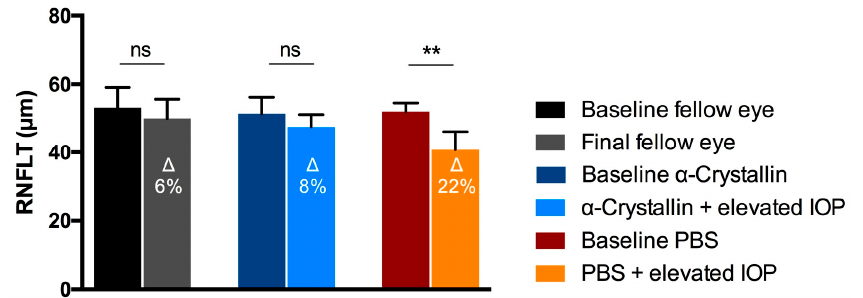
Figure 3. Survey of the retinal nerve fiber layer thickness using optical coherence tomography. Untreated contralateral eyes showed a 6% decrease of the retinal nerve fiber layer thickness (RNFLT) during the time of the study. IOP elevation and α -crystallin B injection effectuated in a loss of ∆ = 8%, while PBS-injected eyes showed a decrease of ∆ = 22% with respect to retinal nerve fiber layer (RNFL) thickness (** p < 0.01, ns—not significant, n = 5, mean ± SD, one-way ANOVA).